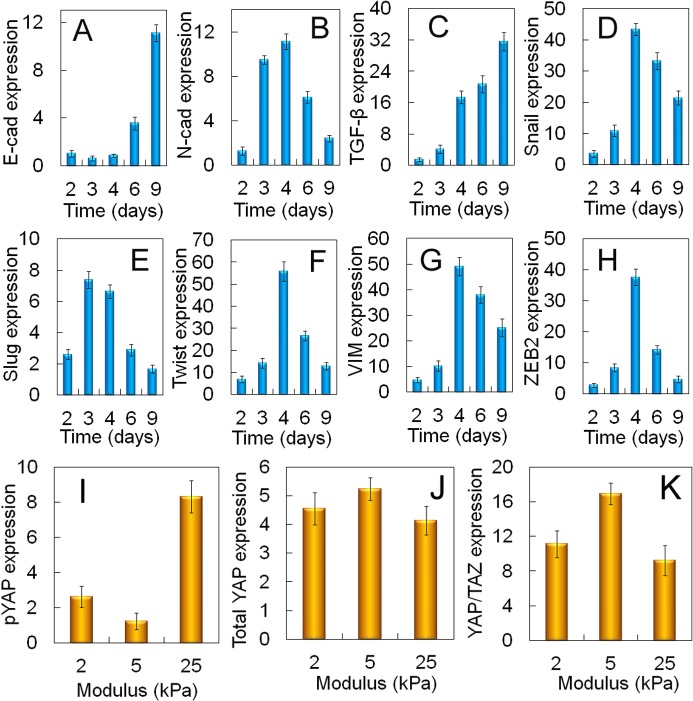
Dependence of tumorsphere growth on EMT marker expression for MDA231 cells.mRNA expression of EMT markers E-cadherin (A), N-cadherin (B), TGF-β (C), Snail (D), Slug (E), Twist (F), Vimentin (G), and ZEB2 (H) for MDA231 cells encapsulated in the un-patterned 5 kPa gel as a function of incubation time. Protein expression of pYAP (I), total YAP (J), YAP/TAZ (K) for the MDA231 cells encapsualted in the un-patterned gel as a function of modulus after 6 days of incubation. An asterisk in (A) indicates a statistically lower marker expression for that time point compared to all other time points. An asterisk in (B,D-H) indicates a statistically higher marker expression for that time point compared to all other time points. An asterisk in (I) indicates a statistically lower protein expression for that modulus compared to the other two moduli. An asterisk in (k) indicates a statistically higher protein expression for that modulus compared to the other two moduli. The p-values for the asterisks in (A,B,D-I,K) are listed in Tables G-O in S2 File. Error bars correspond to mean±1 SD for n = 3.